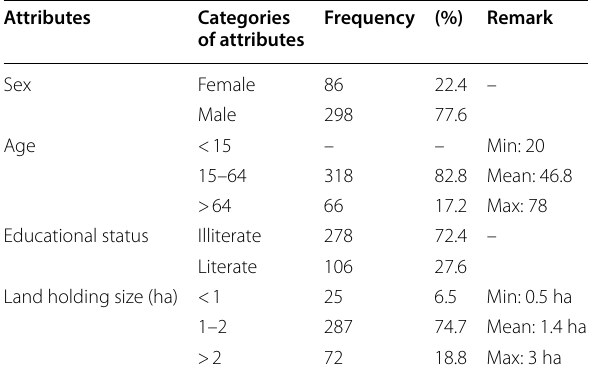
Table 8 Characteristics of the sample population. Source: Survey data (2018)